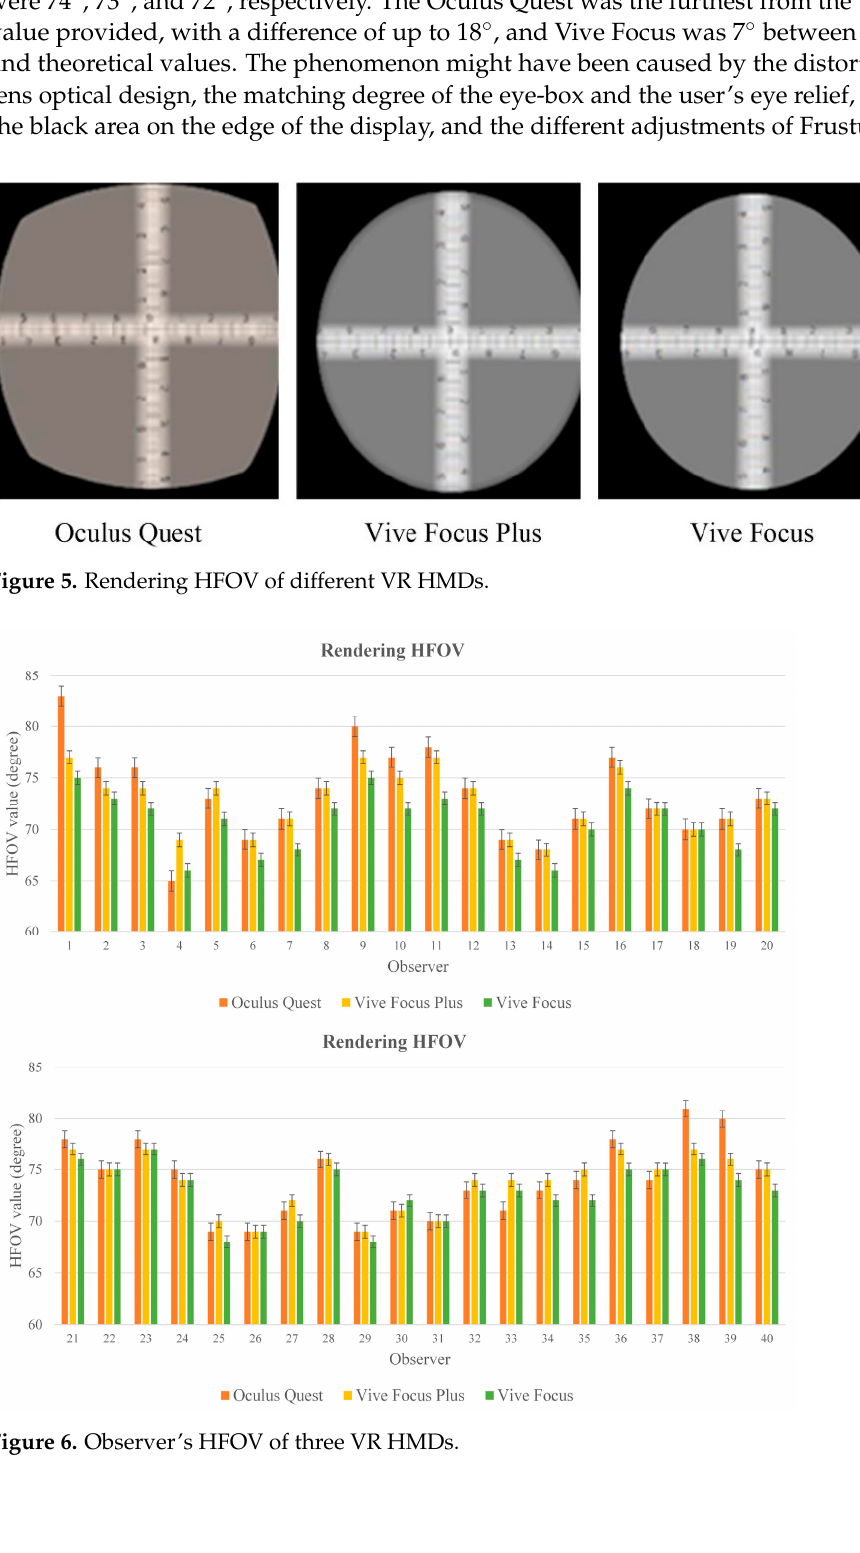
observer variability exam, as shown in Figure 7. The results indicated that Oculus Quest